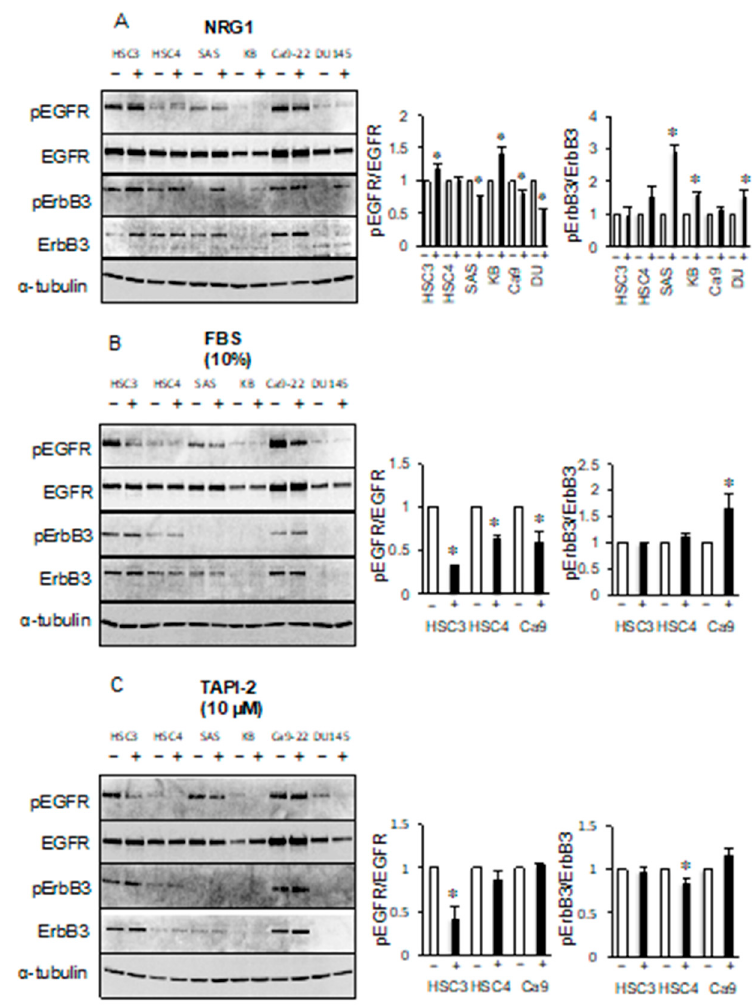
Figure 5. Extracellular signals are not involved in the phosphorylation of ErbB3. Cells were treated with ( A ) neuregulin 1 (NRG1), ( B ) 10% fetal bovine serum (FBS), and ( C ) 10 µ M tumor necrosis factor alpha protease inhibitor 2 (TAPI-2) and the phosphorylation levels of EGFR and ErbB3 were determined by western blotting analysis. α -tubulin was used as the loading control. * Significantly different from control, p < 0.05. Experiments were performed three times independently.